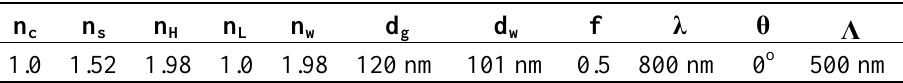
Table 1. Parameters of the GMR